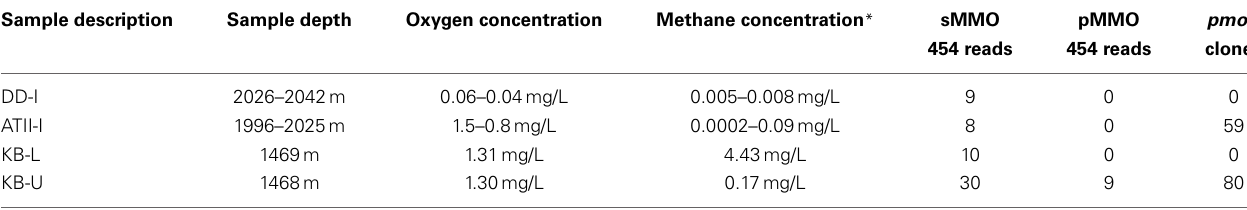
FIGURE 4 | Continued number of sequences within the library that belong to the represented OTUs. The tree was generated using 168 aa. The numbers of sequences collapsed in the selected node are indicated adjacent to the sample name. The tree was calculated using the maximum-likelihood approach with 100 bootstrap replicates. Percentages greater than 50% of bootstrap resampling are